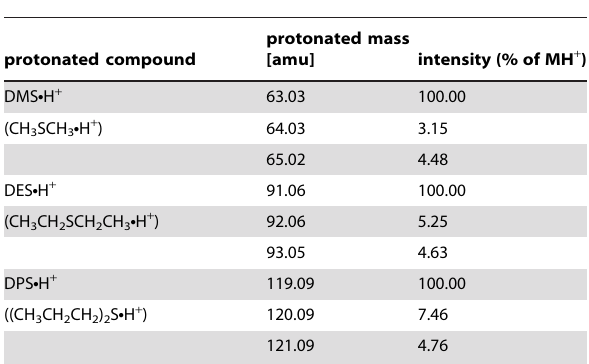
Table 1. Isotopologue ratios for protonated sulfides based on theoretical calculations with the Molecular Weight Calculator [15].